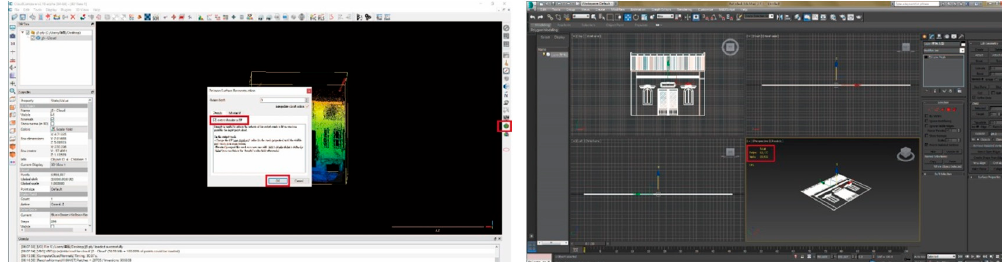
Figure 8. Mesh model creation process in CloudCompare v2.9.1 ® and AutoDesk 3DS MAX 2015 ® .